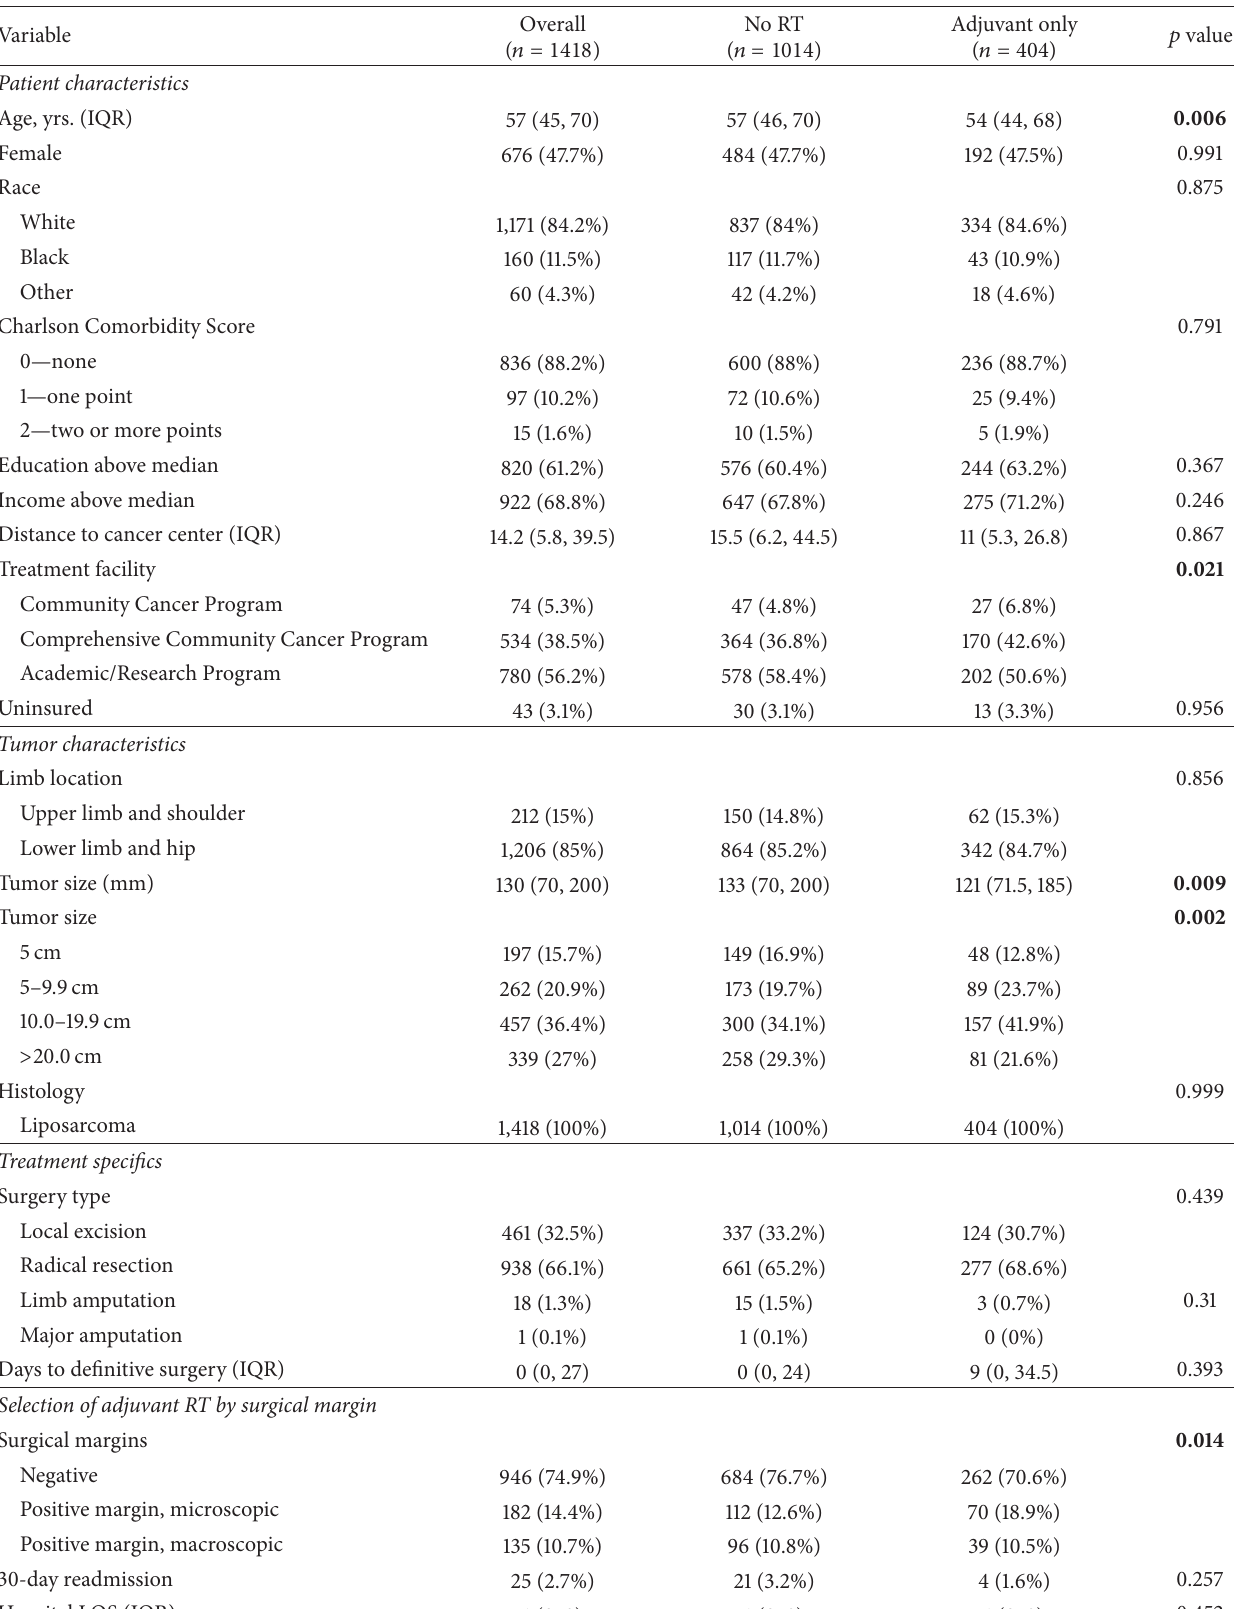
Table 2: Baseline characteristics for patients with well-differentiated liposarcoma